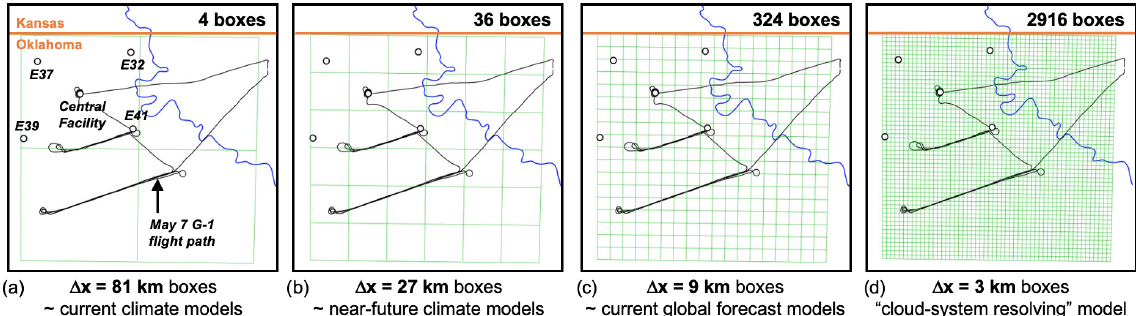
Figure 2. G-1 aircraft flight path on 7 May along with the (a) 81, (b) 27, (c) 9, and (d) 3km boxes used to compute mean aerosol properties from the aircraft measurements.